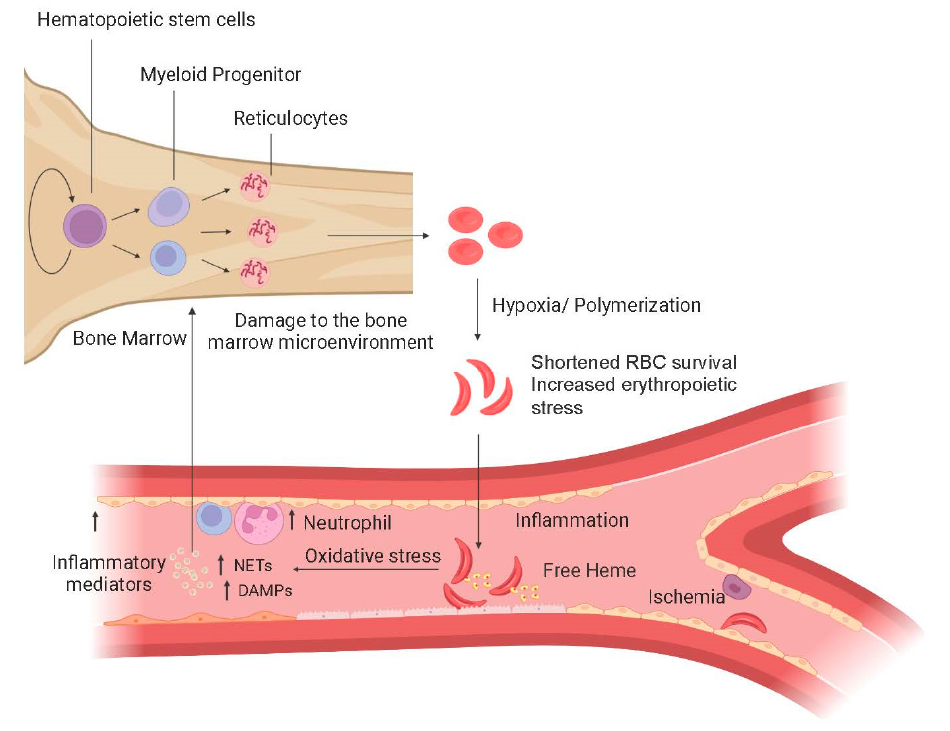
Figure 1. Aspects of SCD pathophysiology that may contribute to clonal hematopoiesis in SCD. Proliferative stress: shortened RBC survival may contribute to high hematopoietic stem cell turnover. Genotoxic stress: free heme, oxidative stress, and other inflammatory mediators damage DNA. Clonal selection: the inflammatory environment may select for clones able to tolerate an unfavorable bone marrow microenvironment. Three processes drive chronic inflammation in SCD: (1) RBC abnormalities; sickle red blood cells (sRBC) damage the endothelium directly through mechanical injury and adhesion. (2) Release of free hemoglobin and heme secondary to sRBC chronic hemolysis; fragile, rigid sRBC have a shortened lifespan, 20 days compared to 120 days. Free hemoglobin and heme result in chronic inflammation, oxidative stress, and vascular damage. The abnormal sRBCs and activated endothelial cells produce a proinflammatory environment; circulating leukocytes and platelets also have an activated phenotype. (3) Ischemia-reperfusion injury secondary to ongoing, intermittent microvascular occlusions promotes chronic inflammation in SCD [8]. Ischemic cells accumulate calcium, exhibit mitochondrial dysfunction and cell swelling, and release major inflammatory-damage-associated molecular patterns (DAMPs) that promote multiple inflamma- tory pathways, including neutrophil extracellular trap formation and inflammasome assembly